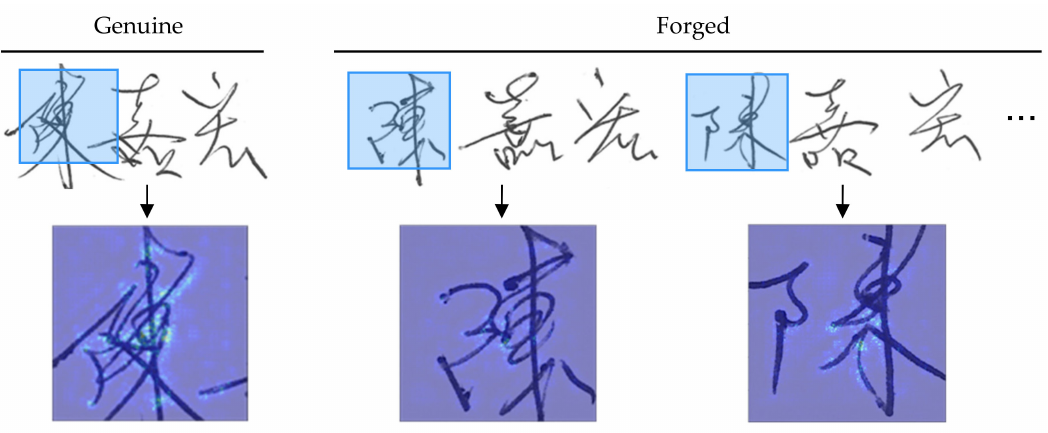
Figure 6. Saliency maps for real collected Chinese